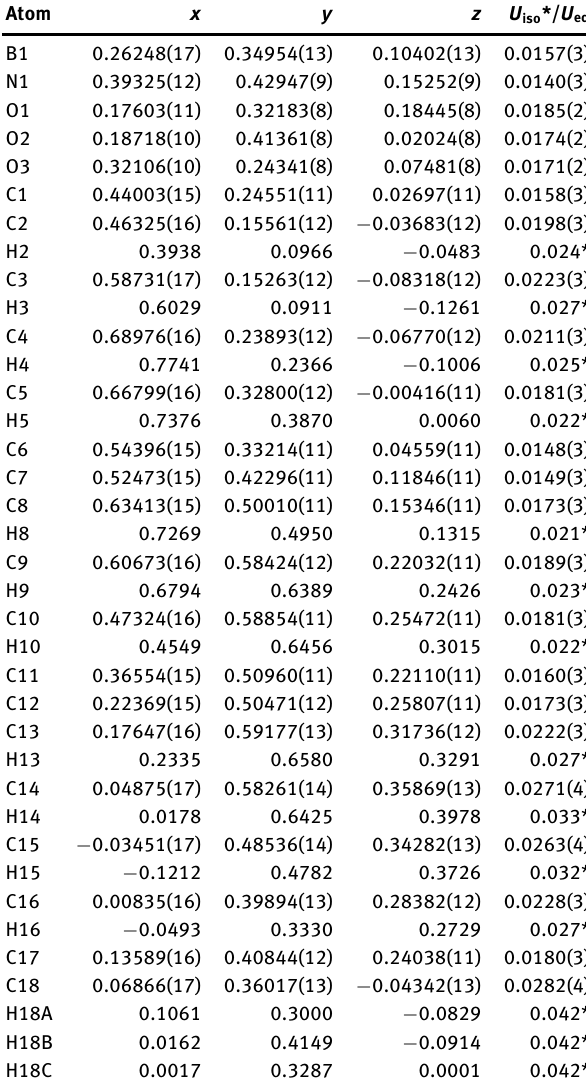
Table 2: Fractional atomic coordinates and isotropic or equivalent isotropic displacement parameters (Å 2 ).